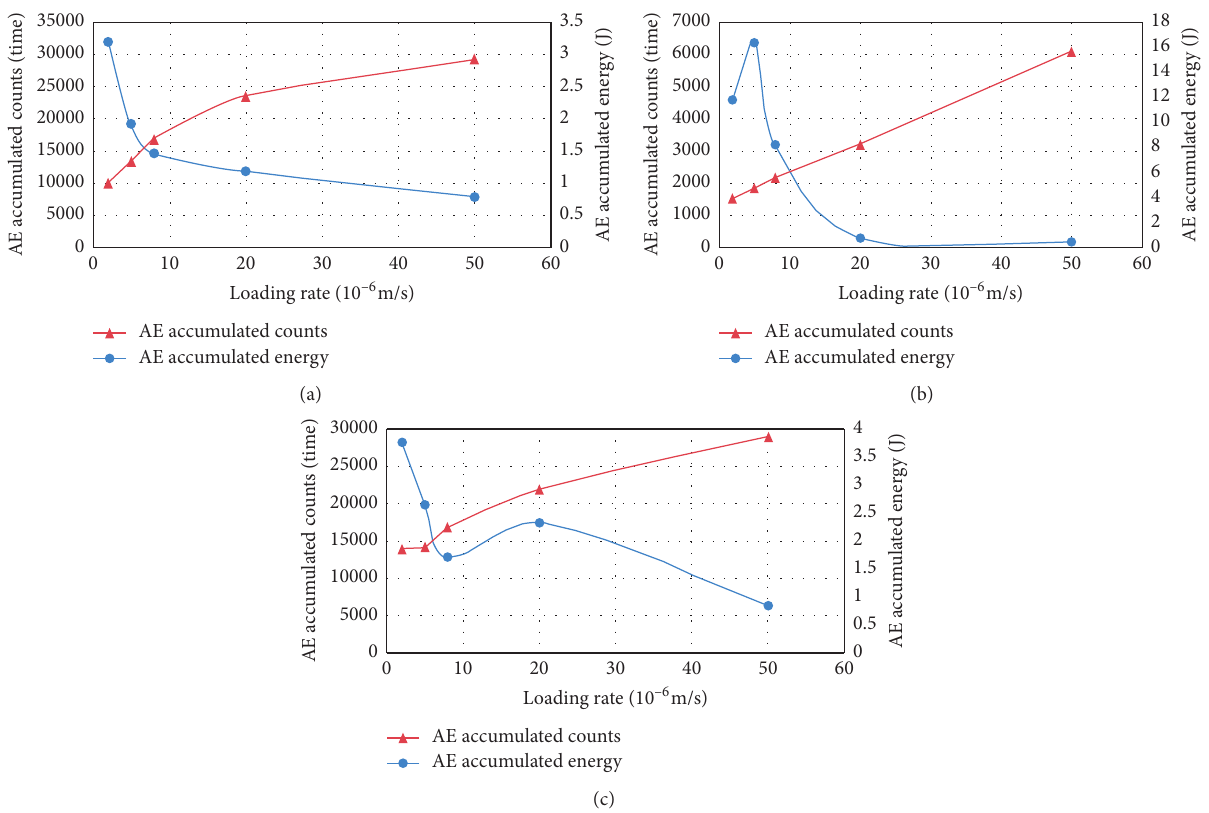
Figure 11: Relationship curve between AE accumulated energy, AE accumulated counts, and loading rate of three kinds of numerical specimen. (a) Numerical specimen A. (b) Numerical specimen B. (c) Numerical specimen C.